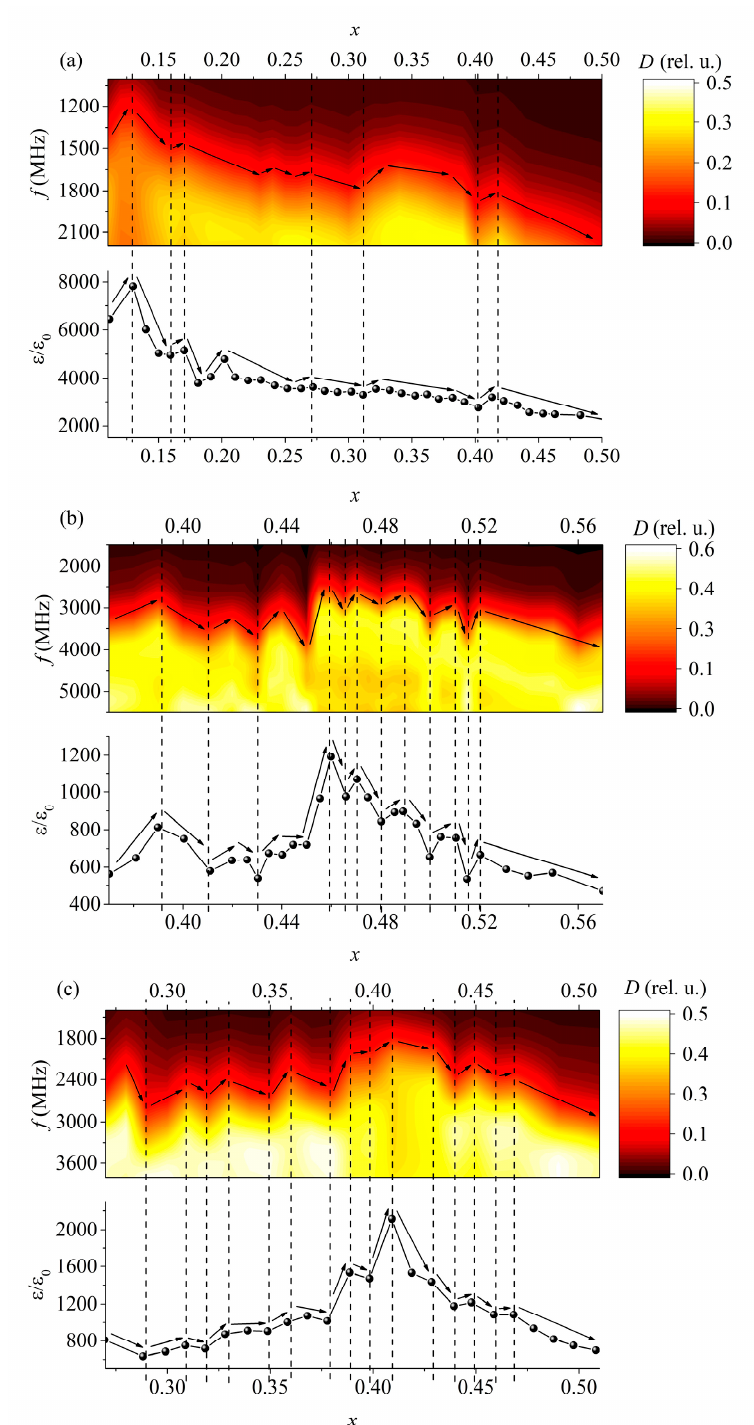
Figure 4. Comparison of the absorption coefficient ( D ) and relative permittivity spectra ( ε / ε 0 ) [19] dependences on the components’ concentration of various PMN-PZT-PG solid solutions: ( a ) 0.98( x PT–0.05PZ–( x − 1)PMN)–0.02PG; ( b ) 0.98( x PT–( x − 1)PZ–0.05PMN)–0.02PG; and ( c ) 0.98( x PT–( x − 1)/2PZ–( x − 1)/2PMN)–0.02PG. The dashed line shows the extreme values of the permittivity; the arrows show the trends for the absorption band to shift in frequency and the changes in the permit- tivity.